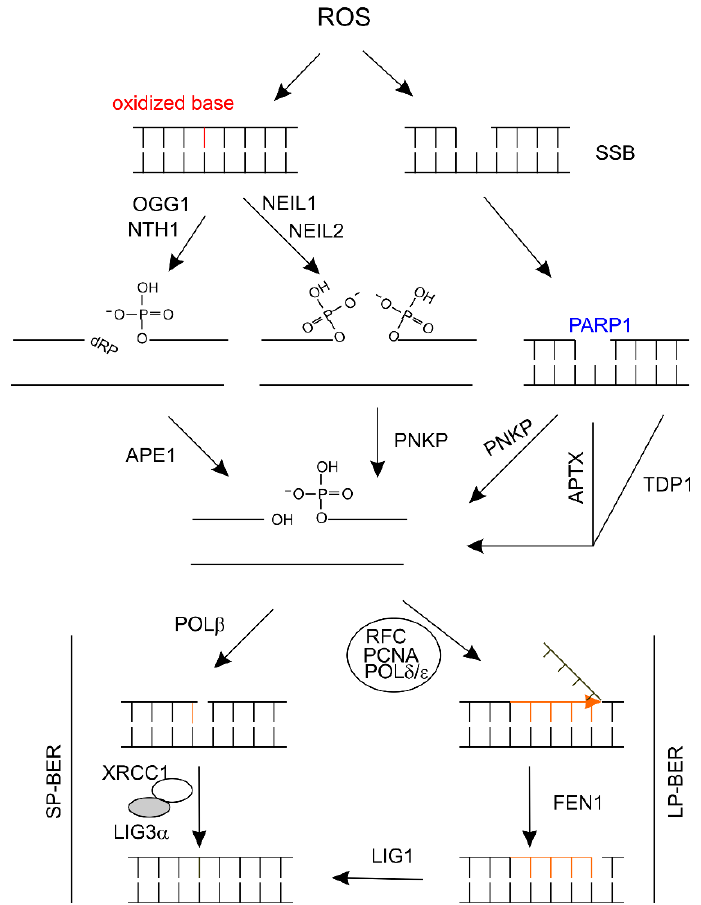
Figure 3. An illustration demonstrating BER. ROS induces oxidized base lesion or SSB. The oxidized bases are removed by DNA glycosylase OGG1 and NHT1 or NEIL1 and NEIL2; the ends are then processed, followed by filling the gap with synthesis of a single nucleotide or 2 ‐ 8 nucleotides; ligation via a ligase will then complete the repair. SSB was first recognized by PARP1; different ends produced